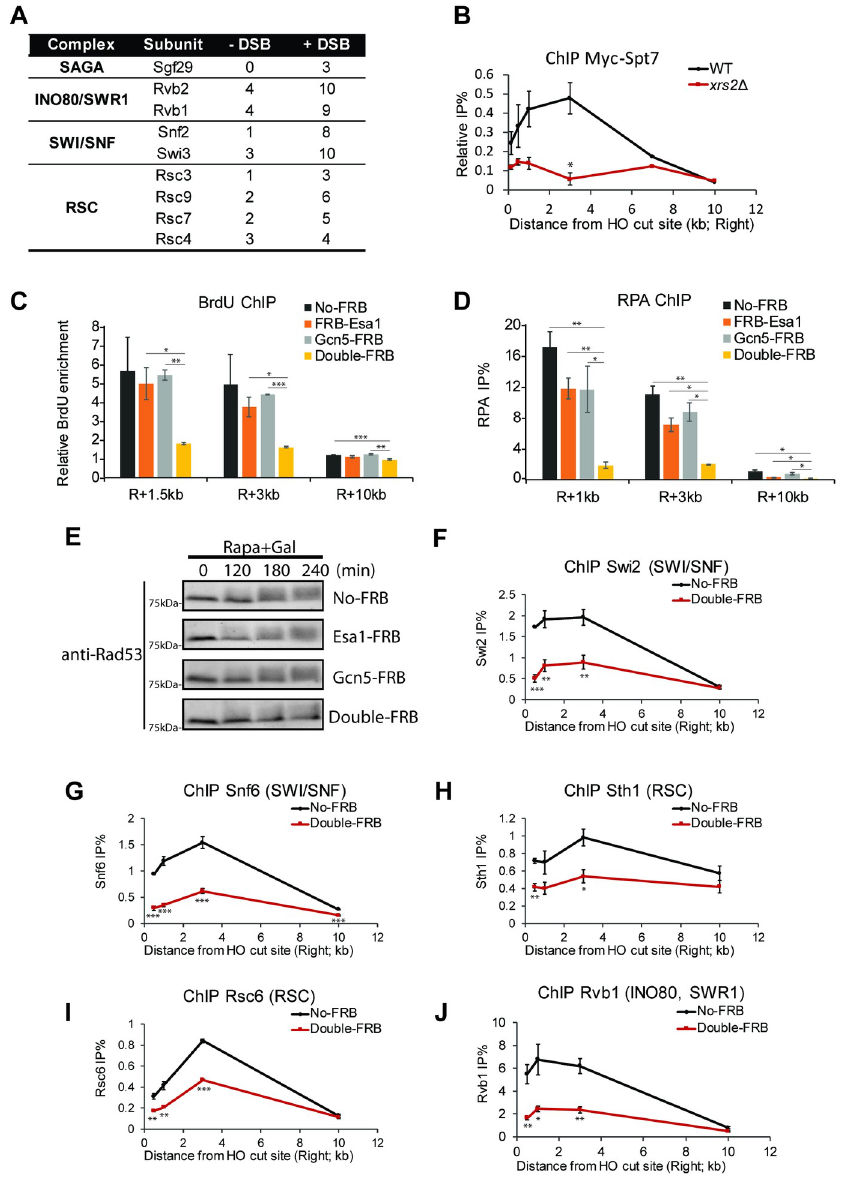
Fig 4. Essential collaboration of NuA4 and SAGA HAT complexes at DSBs to allow DNA end resection and recruitment of ATP-dependent chromatin remodelers. A) List of protein components of chromatin remodeling/ modifying complexes and number of total peptides detected in ChIP of Flag-Rfa1 followed by MS analysis from cells after 0 or 90 min of HO induction [5], showing increased association of remodelers but also a component of the SAGA HAT complex. B) ChIP-qPCR assay of Myc-Spt7 (SAGA scaffold subunit) in WT and xrs2 Δ cells after 3hr of HO induction with galactose. % of IP/input is shown at different locations near the DSB after subtraction of the signal in untagged strain. C) ChIP-qPCR assay of BrdU in indicated FRB-tagged strains after 3hr galactose induction in the presence of rapamycin to measure ssDNA production (as in Fig 1H). BrdU enrichment was normalized on control locus (inter V). D) ChIP-qPCR as in (B) but measuring resection through anti-RPA, showing again full loss of resection when Esa1 and Gcn5 are both depleted. E) DNA damage checkpoint activation measured by Western blotting of Rad53 (Santa cruz, sc-6749) from whole cell extracts after 0, 2, 3, 4hr of galactose induction in presence of rapamycin, showing slower migrating signal upon activation by DNA damage, which is lost after depletion of both Esa1 and Gcn5. F-J) Recruitment of ATP-dependent chromatin remodeling complexes at locations near the HO DSB as measured by ChIP-qPCR with specific antibodies after 3hr of galactose induction in presence of rapamycin. The Esa1/Gcn5 double depletion shows clear defects in recruitment of these factors. Error bars represent range from biological duplicates. (Statistical analyses were performed by one-tailed t-test: � p < 0.05, �� p < 0.01, ��� p < 0.001; and multiple comparisons significance for C and D was also confirmed by one-way ANOVA followed by Tukey test).